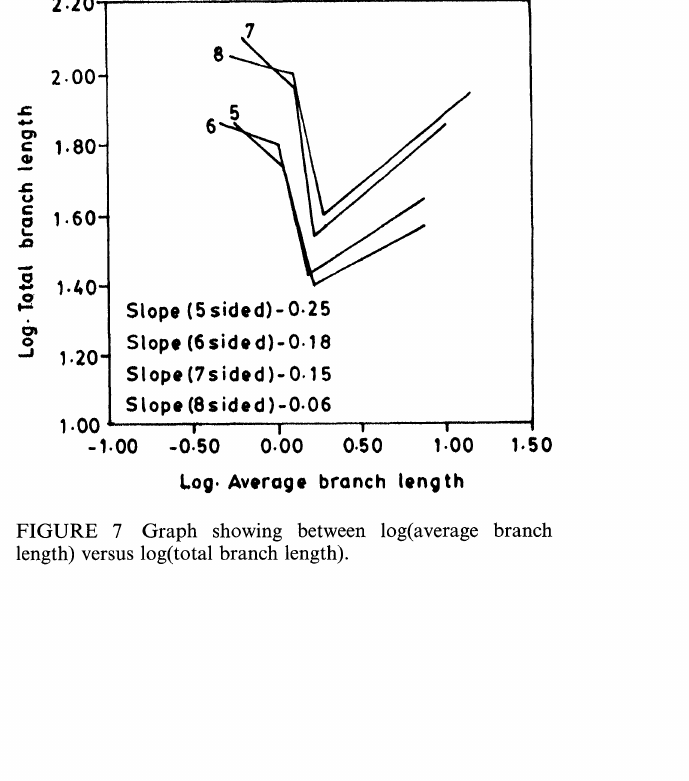
FIGURE 6 Graph showing between log(no, of skeletons) versus log(average length).